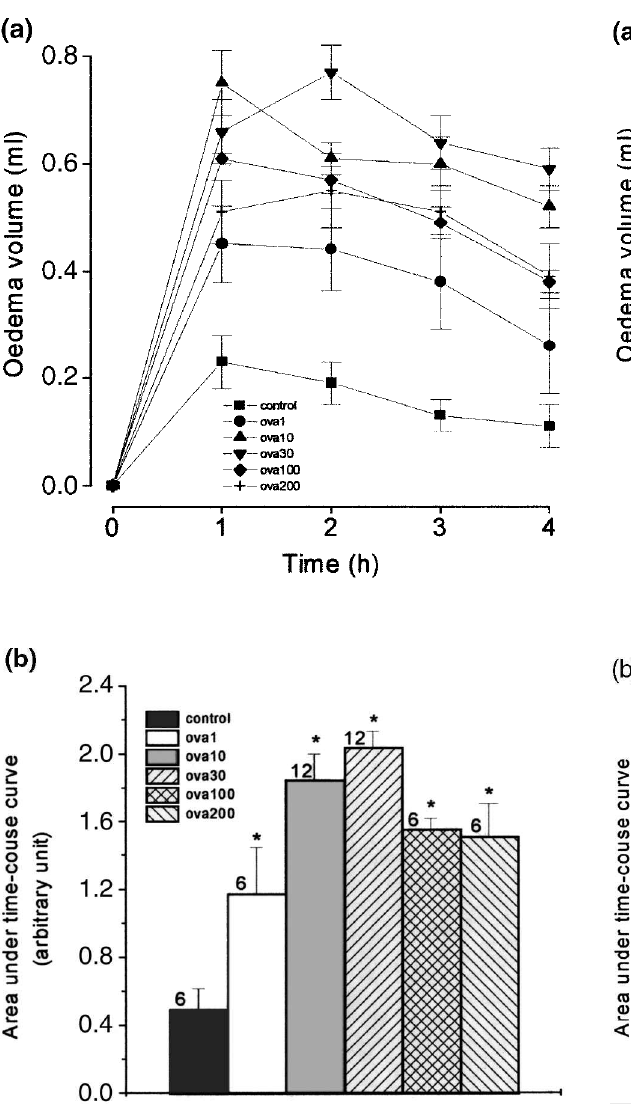
FIG. 2. Time course of sensitization of rats prior induction of ovalbumin (ova) – paw oedema. (a) Oedema induced by ova (10 m g/paw) injected in sham-sensitized (control), non-sensi- tized (n.sensitized) or sensitized sens rats with ova (30 m g/rat) at different days (d) after sensitization. (b) The area under the time-course curve was determined using a trapezoidal rule. Each point represents the mean ± SEM for the number of animals ( n = 6). Significant differences compared with respective controls: * compared with the sham-sensitized group (control) or ** compared with the not-sensitized group ( p < 0.05; ANOVA, Student’s t